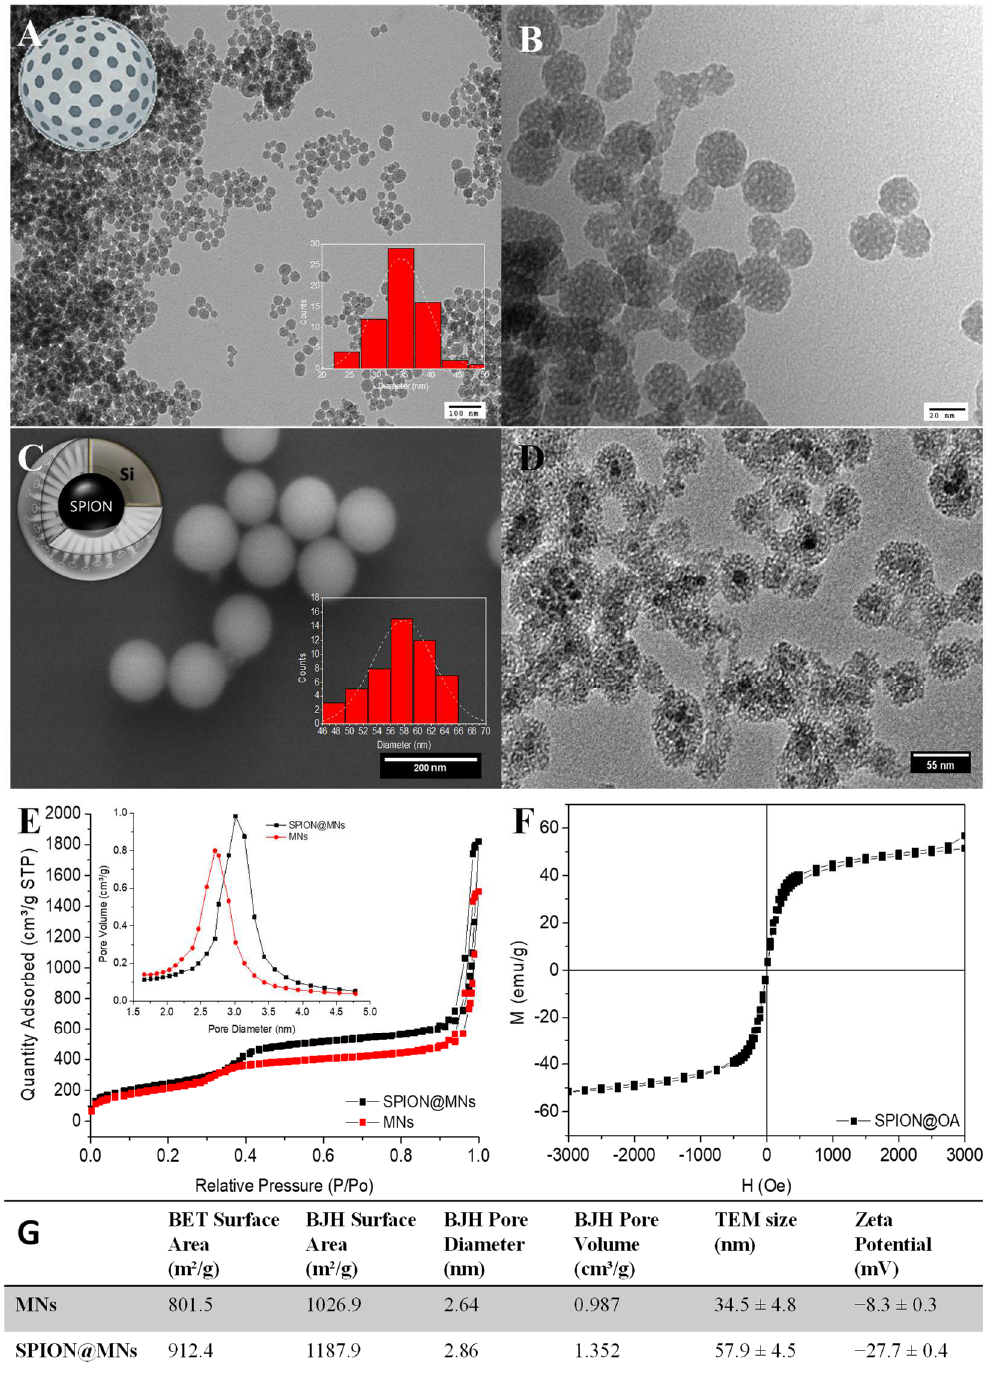
Figure 4. Physical characterization of MNs and SPION@MNs: MNs TEM micrographs confirming the particles’ mesoporosity, at 100 nm scale ( a ) and close up at 20 nm scale ( b ); inset: particle size distribution ( n = 65). SPION@MNs SEM image, scale at 200 nm; inset: particle size distribution ( n = 50) ( c ). TEM micrograph of SPION@MNs depicting single Fe 3 O 4 magnetic cores encapsulated within silica mesoporous matrix, at 55 nm scale ( d ). The 72 K N 2 -isotherms of both MNs and SPION@MNs systems, again confirming their mesoporosity and availability for drug encapsulation ( e ). SPION@OA cores’ magnetization saturation curves ( f ). Summary of both MNs and SPION@MNs’ physical properties from surface area to pore diameter and volume, TEM size and surface zeta potential ( g ).